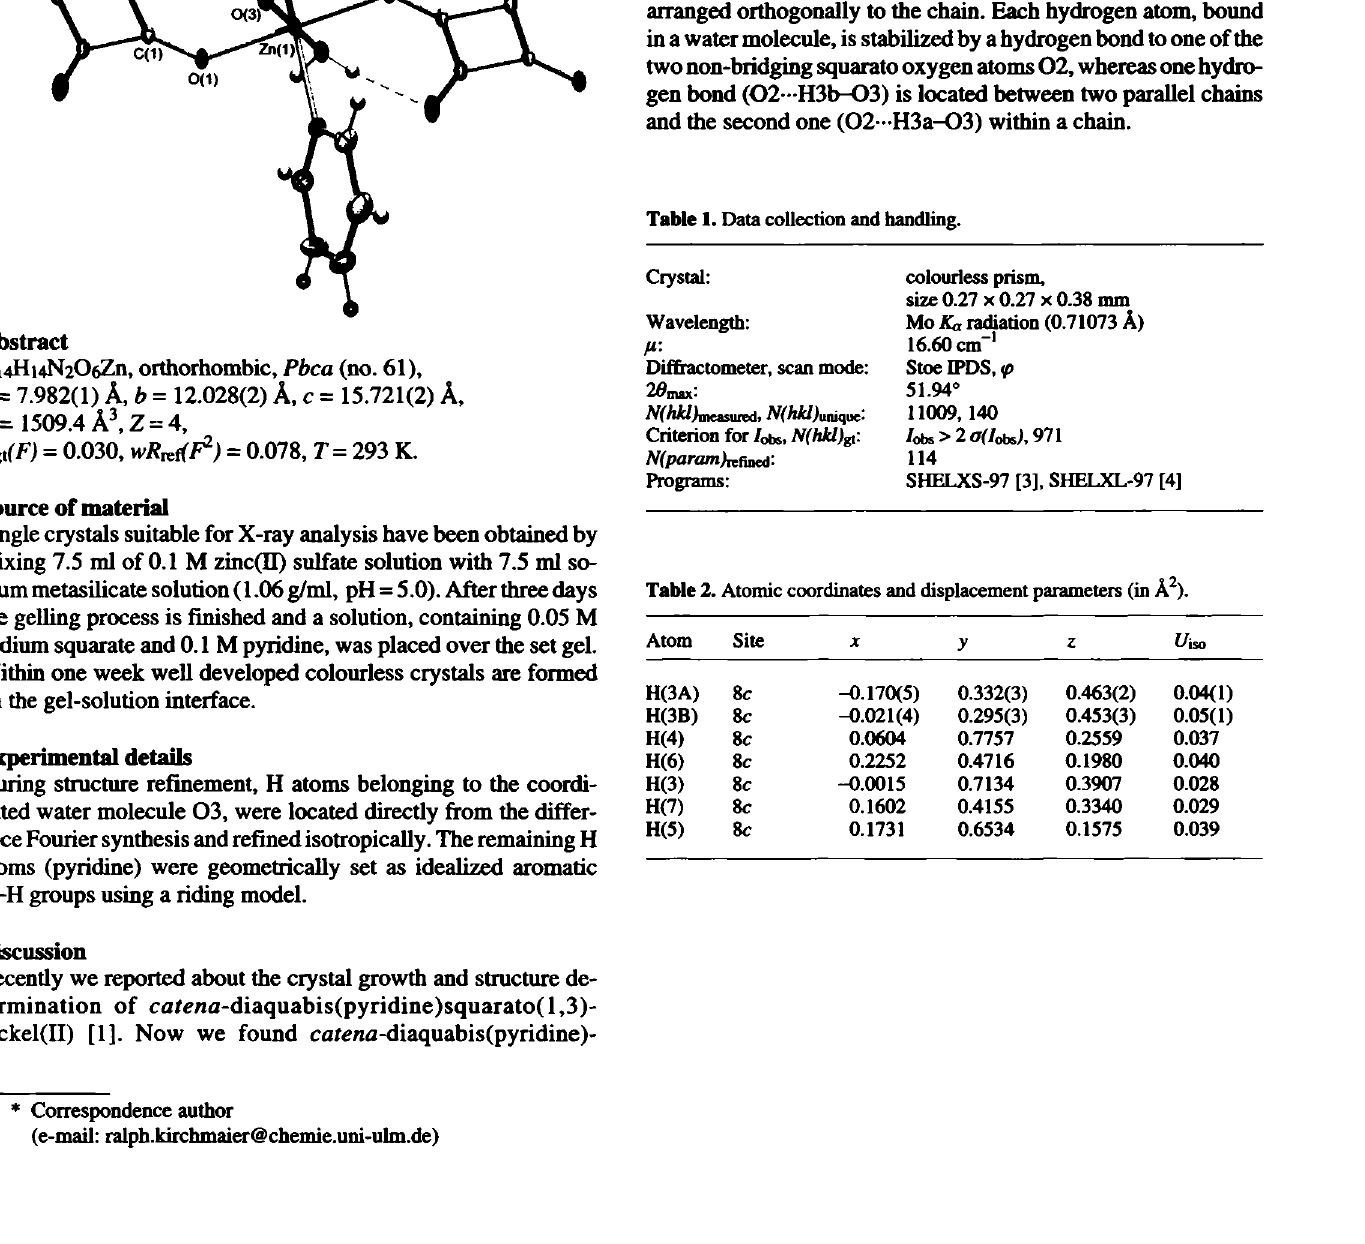
Table 1. Data collection and handling.